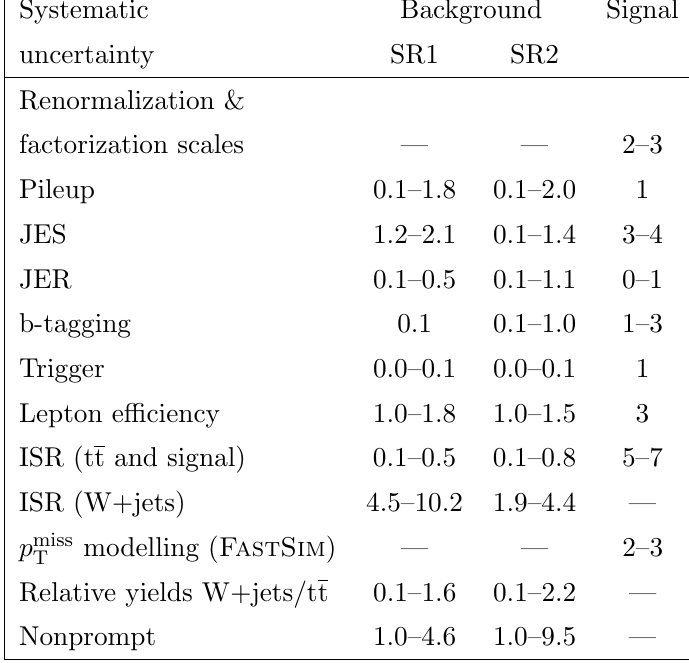
Table 3 . The CC search: typical ranges for relative systematic uncertainties (in %) on the total background prediction and signal prediction in the main SRs. The \|" means that a certain source of uncertainty is not